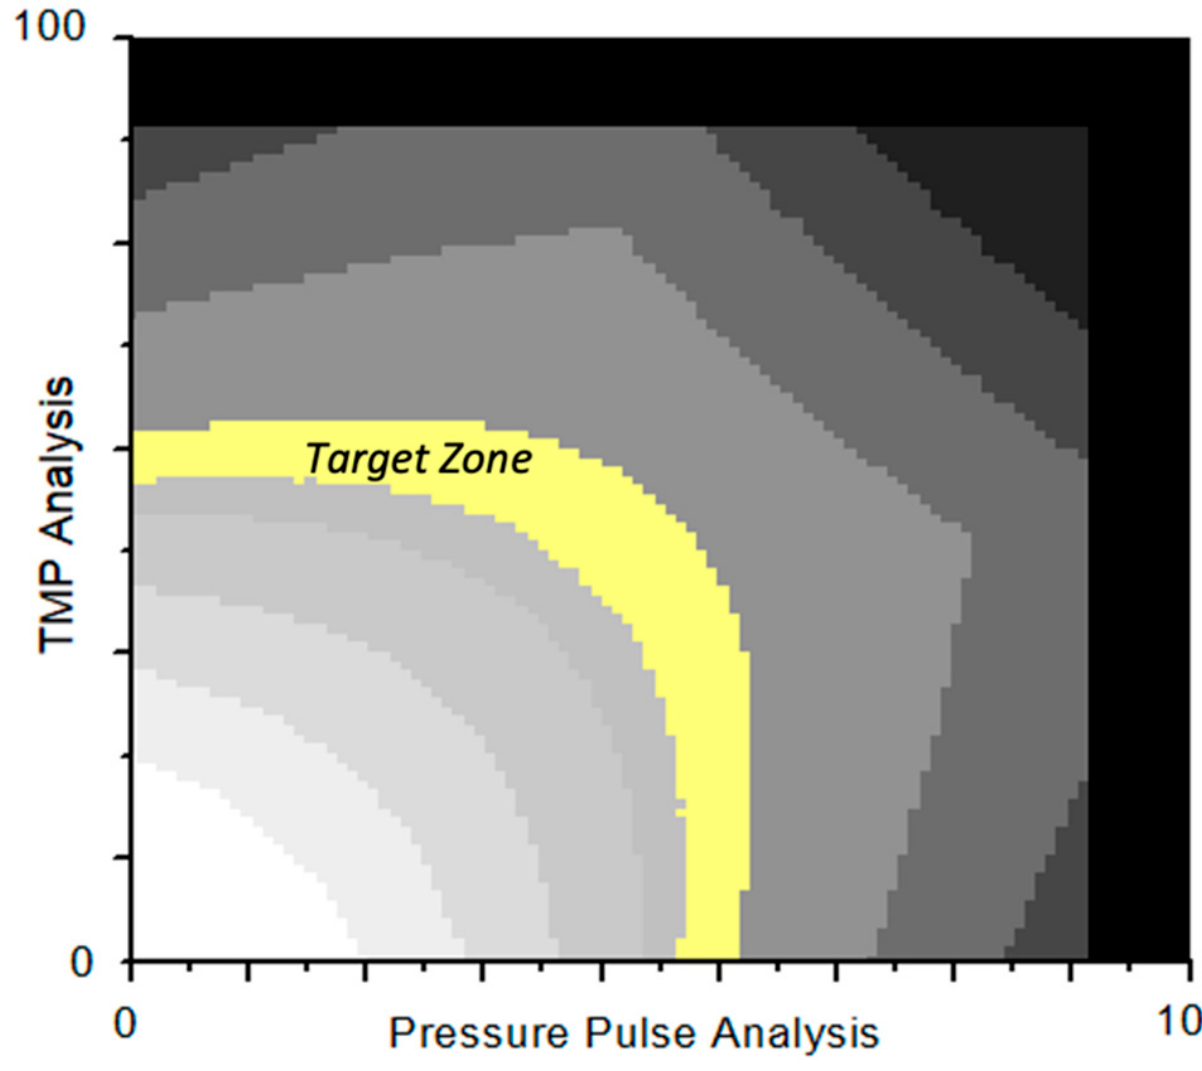
Figure 2. Substitution target matrix of AutoSub plus™. When the assessment is below the target zone, the substitution rate is increased to raise the stress in the membrane. When the assessment is above the target zone, the substitution rate is reduced to lower the stress in the membrane.